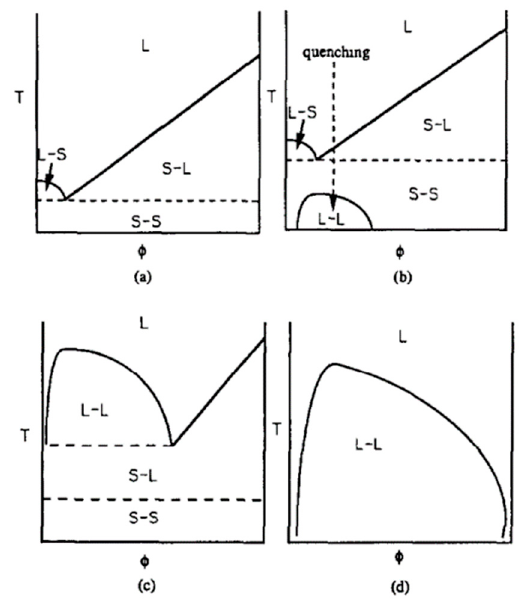
Figure 4. Schematic representation of the different TIPS phase diagrams, ( a ) the interaction parameter is negative and minimum, ( b ) the interaction parameter is less favorable, ( c ) the interaction parameter is high, ( d ) the interaction parameter is positive, adapted from [65] .